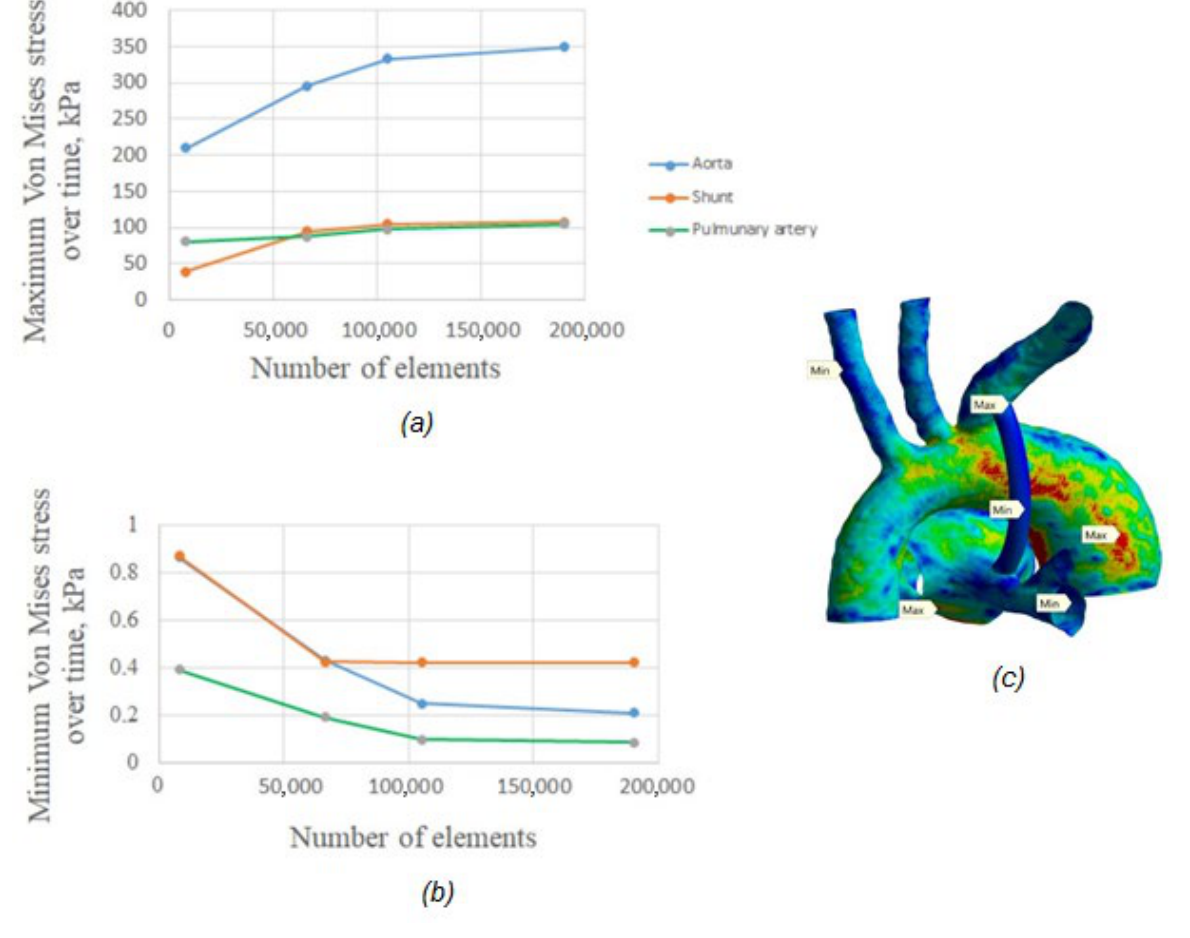
Figure 2. Maximum stress variations with respect to the number of mesh elements for solid domain: ( a ) mesh dependency tests for maximum von Mises stress, ( b ) mesh dependency tests for minimum von Mises stress, ( c ) maximum and minimum values for aorta, shunt, and pulmonary artery.